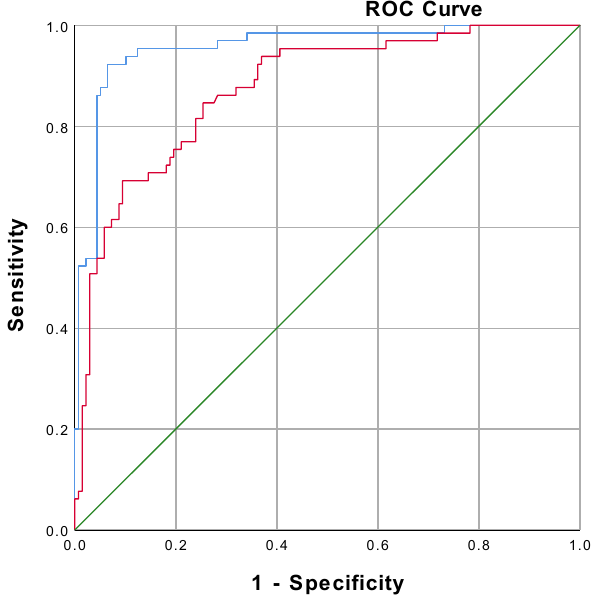
Figure 3. Comparison of ROC curve between ANN model and LR model. Table 4. Model evaluation and performance matrices.